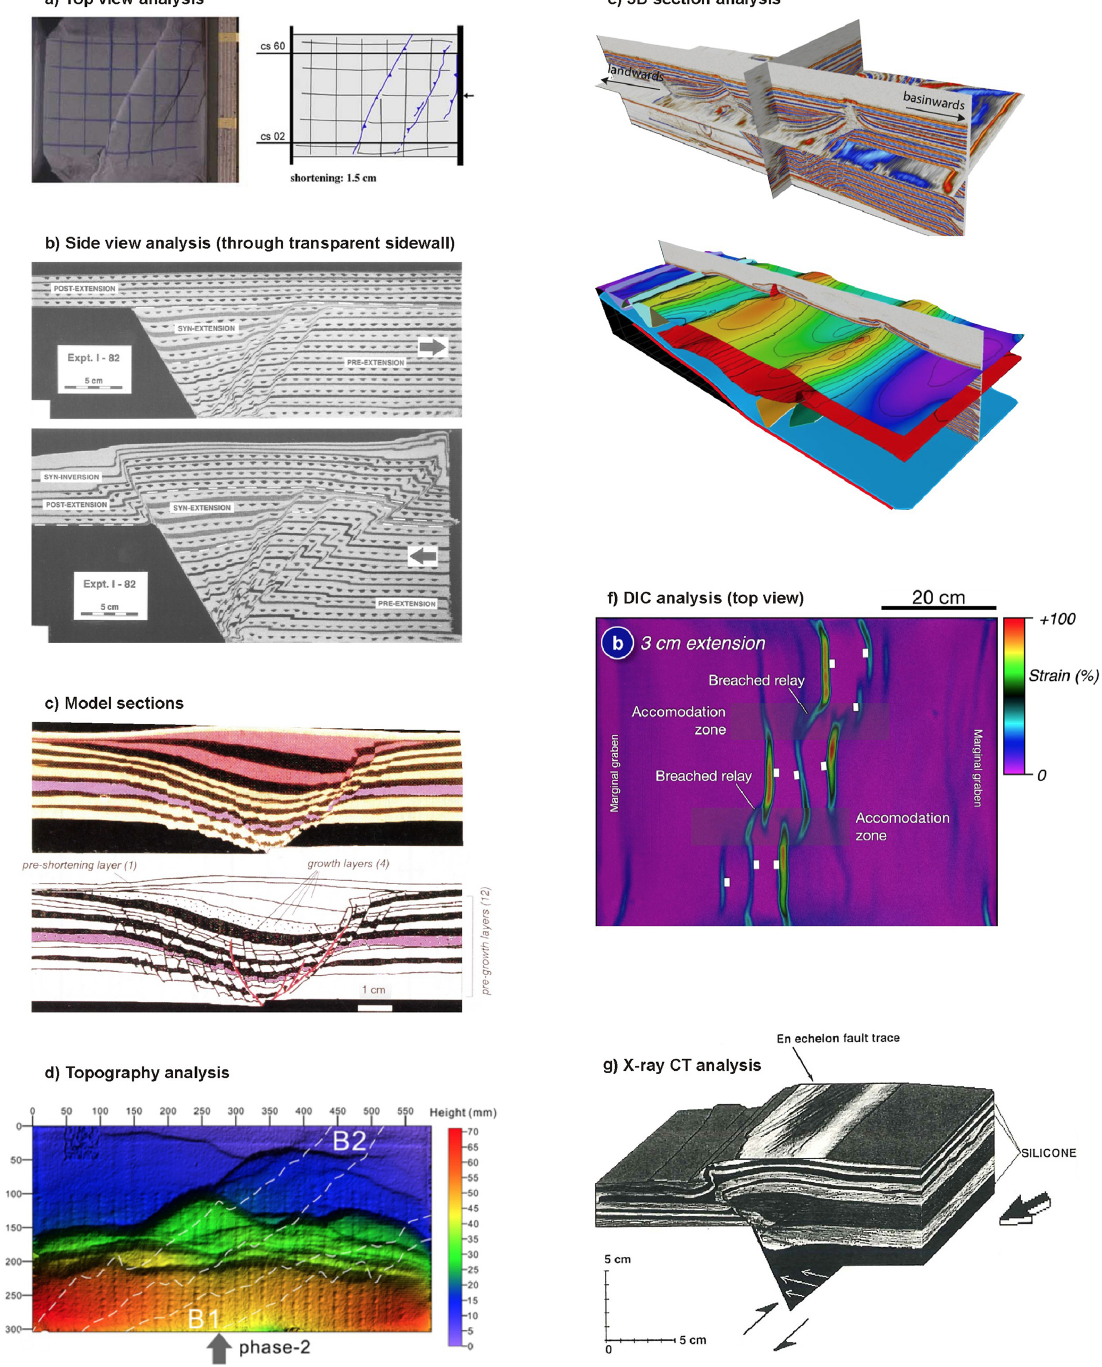
Figure 7. Examples of techniques used for the analysis of basin inversion models. (a) Top-view image from an inversion model by Panien et al. (2005), reproduced with permission from Elsevier. (b) Side-view imagery of an inversion model with a fixed rigid footwall block set-up after McClay (1995), reproduced with permission from the Geological Society, London. (c) Cross-section of an inversion model with a base plate set-up after Eisenstadt and Withjack (1995), reproduced with permission from the Geological Society, London. (d) Topography map of a basin inversion model by Deng et al. (2019), obtained via surface laser scanning. (e) Advanced analysis of model cross-sections in 3D seismic interpretation software by Roma et al. (2018b), reproduced with permission from the Geological Society, London. (f) Strain map of a basin inversion model by Dooley and Hudec (2020), obtained through digital image correlation (DIC) analysis. (g) X-ray CT analysis of an inversion model involving a mobile basement block after Letouzey et al. (1995) (AAPG © 1995, reprinted by permission of the AAPG, whose permission is required for further